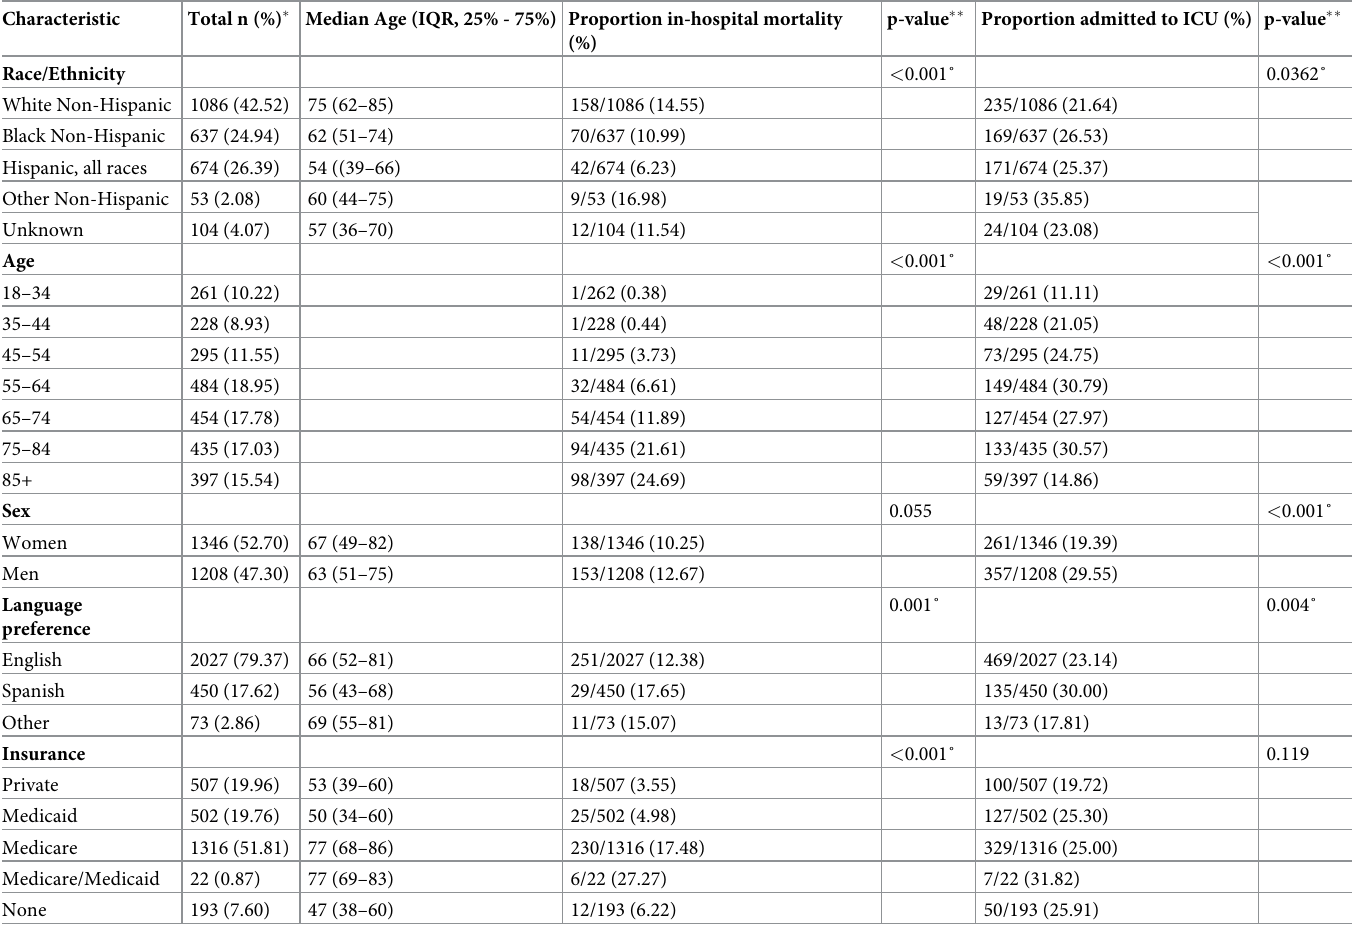
Table 1. Clinical outcomes by sociodemographic characteristics of COVID+ patients, n = 2554.